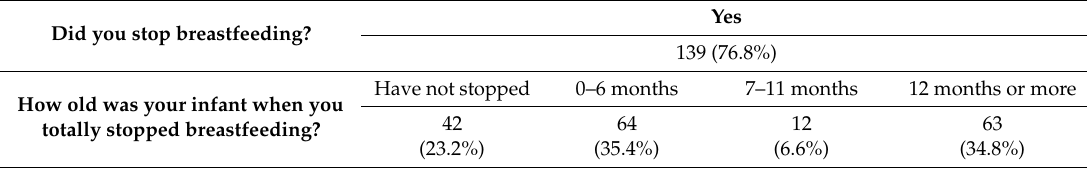
Table 3. Prevalence of outcomes 1 and